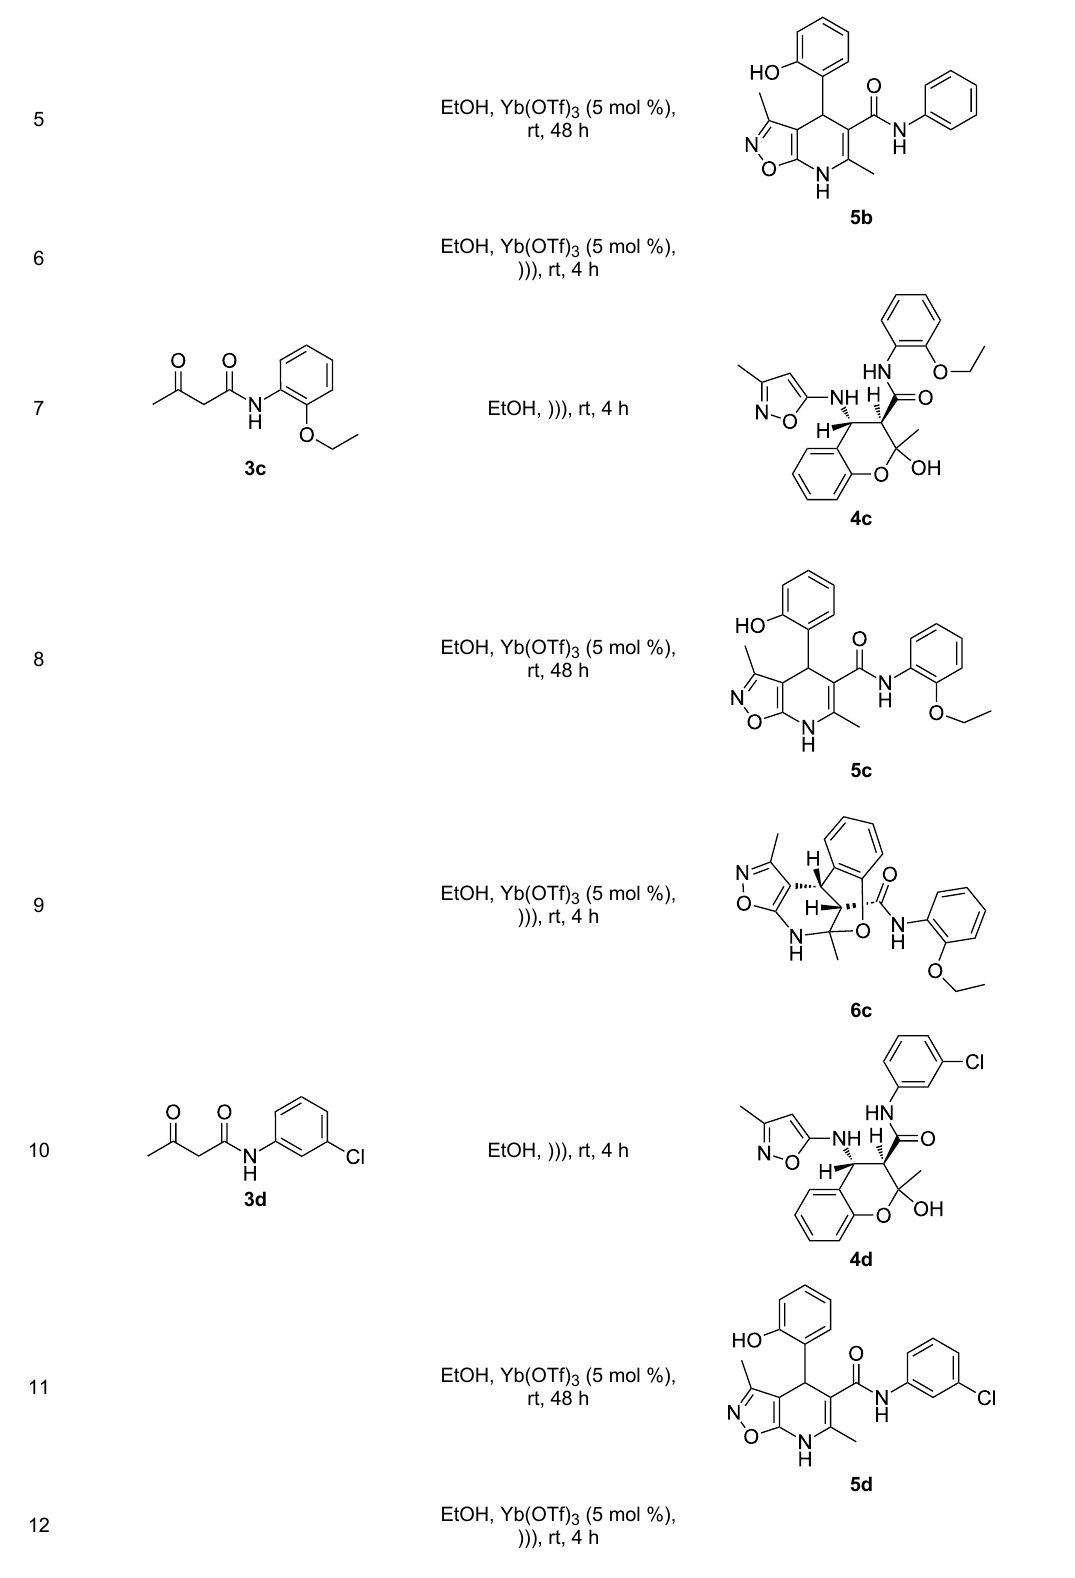
Table 3: Three-component heterocyclization of 5-amino-3-methylisoxazole ( 1 ), salicylaldehyde ( 2 ) and N -aryl-3-oxobutanamides ( 3a – h ).